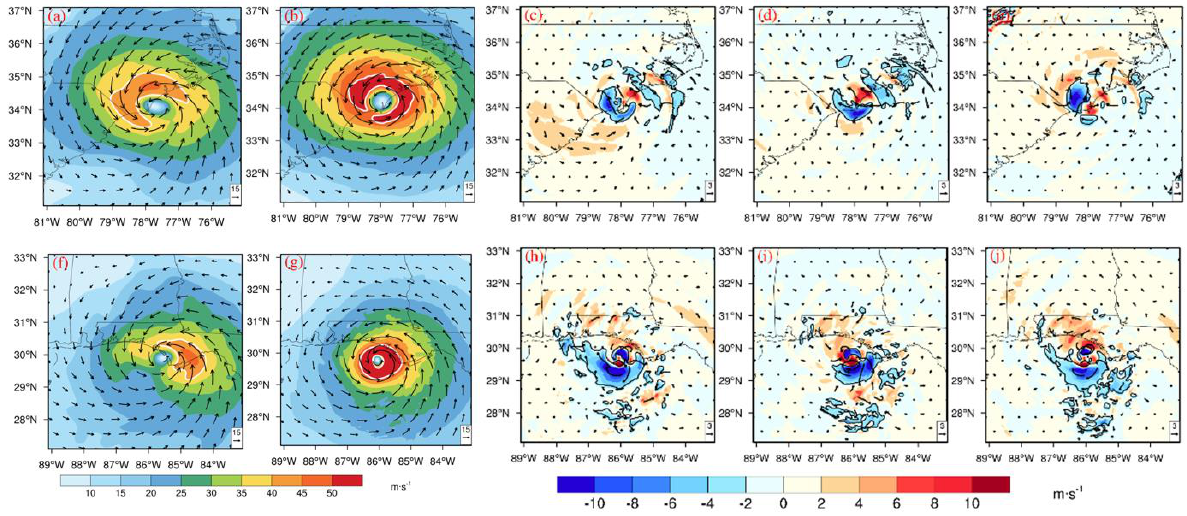
Figure 4. Horizontal wind (unit: m · s − 1 ) at 925 hPa for ( a , b ) Florence (at 1200 UTC on 14 September 2018) and ( e , f ) Michael (at 1800 UTC on 10 October 2018) at landfall. Colored contours represent wind speed, and vectors represent wind direction. Panels ( a , f ) the wind field of HRRR for Florence and Michael; panels ( b , g ) are the wind speeds and vectors for forecasts of Exp. FCO and Exp. MCO, respectively; panels ( c – e ) are the differences from Exp. FCO for the forecasts of Exp. FCOAS, Exp. FCOCY-2-50, and Exp. FCOASCY-2-50, respectively; and panels ( h – j ) are the differences from Exp. MCO for the forecasts of Exp. MCOAS, Exp. MCOCY-2-50, Exp. MCOASCY-2-50,